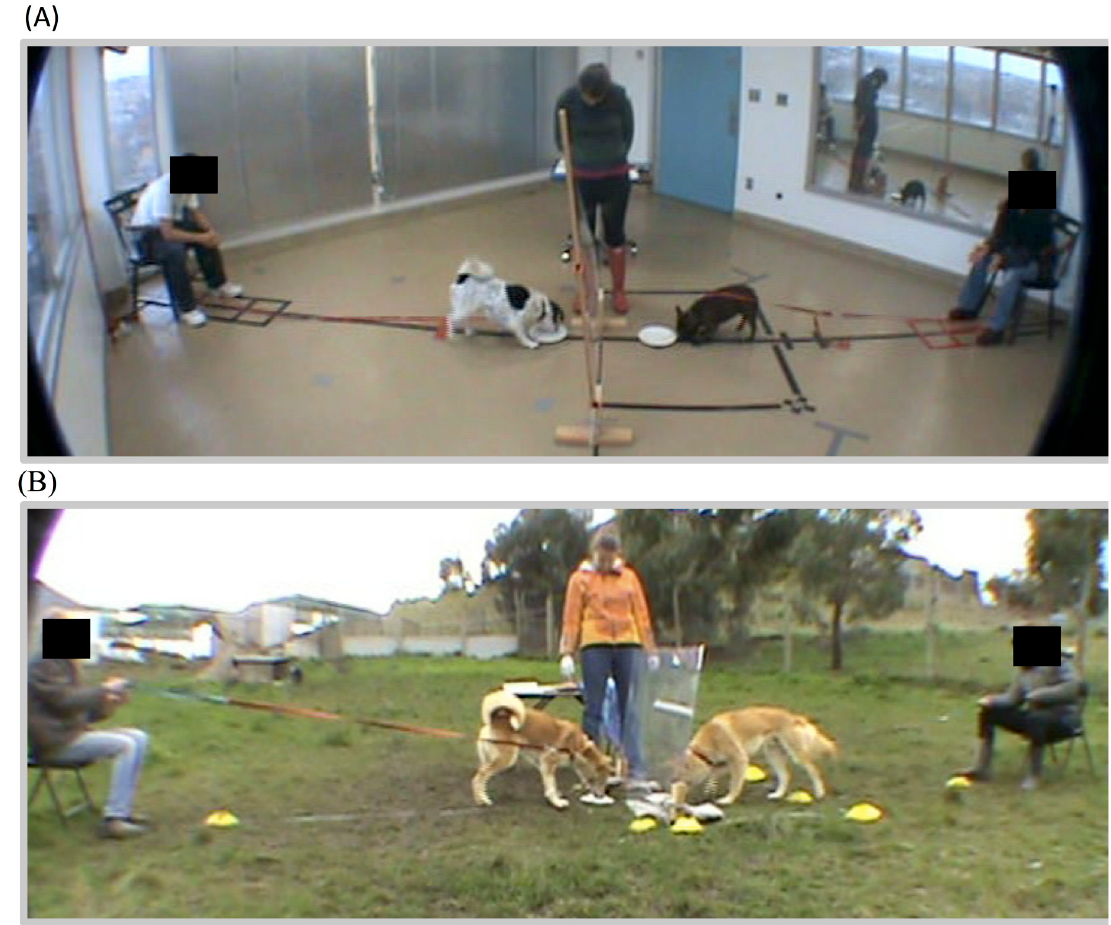
Fig 1. Testing set-up for dogs (A) and dingoes (B). The subject’s handler and subject sat on the right of a transparent barrier and the partner and the partner’s handler sat on the left of the barrier. The experimenter stood in the middle of the testing space, called the subjects, and distributed rewards on plates. A subject was considered to have approached when he/she had two front paws in the box surrounding the plate (box marked by black tape for dogs and yellow cones and blue ribbon for